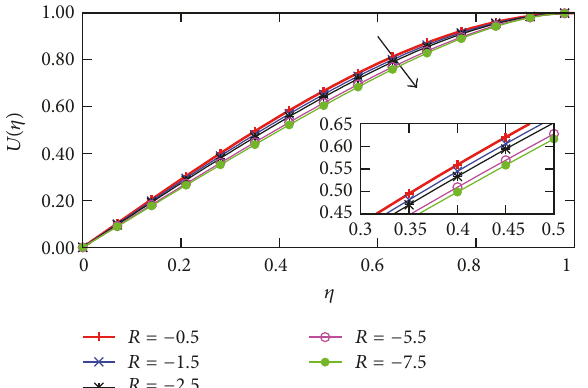
Figure 8: Effect of negative Reynolds number 𝑅 on the normal velocity.